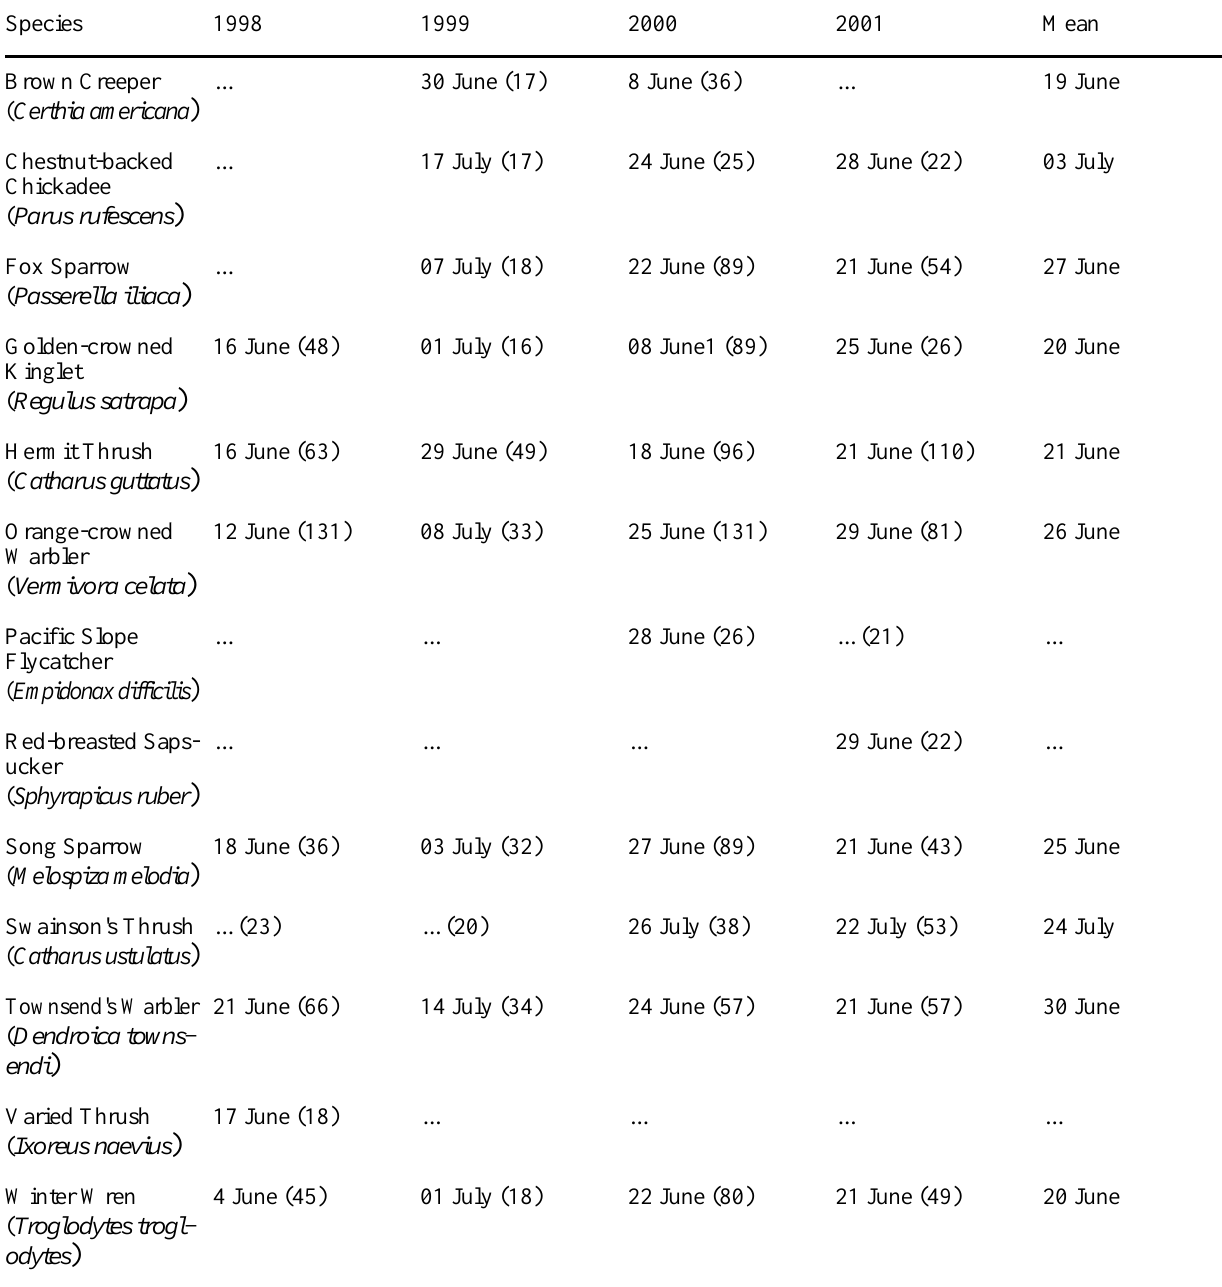
Table 2 . Dates of first capture of hatching-year birds at Laskeek Bay. Sample sizes in parentheses are the numbers of individuals trapped and aged during systematic mist-netting